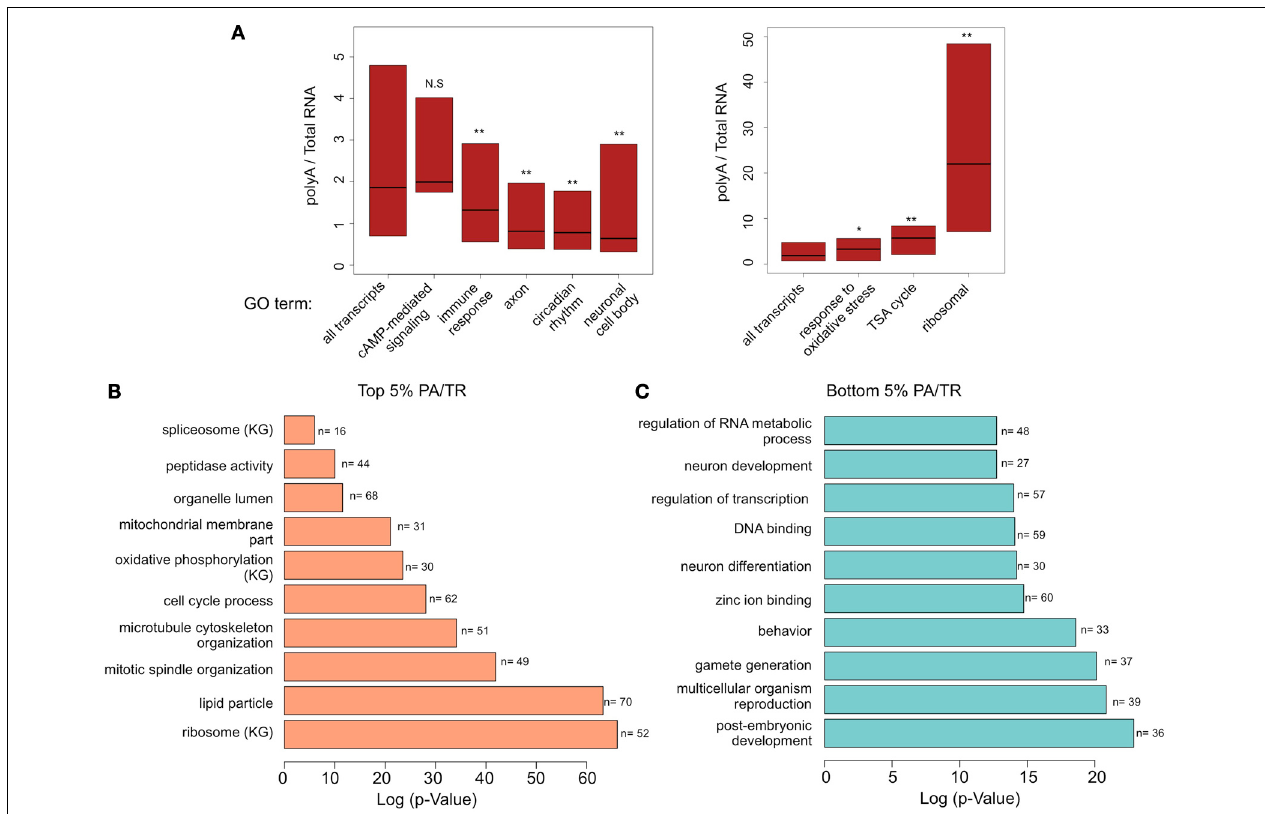
∗∗ p < 0 . 0001. NS, non-significant. (B) Results of DAVID functional annotation analysis to examine GO enrichment in genes with the top 5% and (C) bottom 5 % PA/TR values. The data presented is log transformed p -Value (FDR corrected) of GO terms or KEGG pathways (KG) found to be enriched in the tested group of